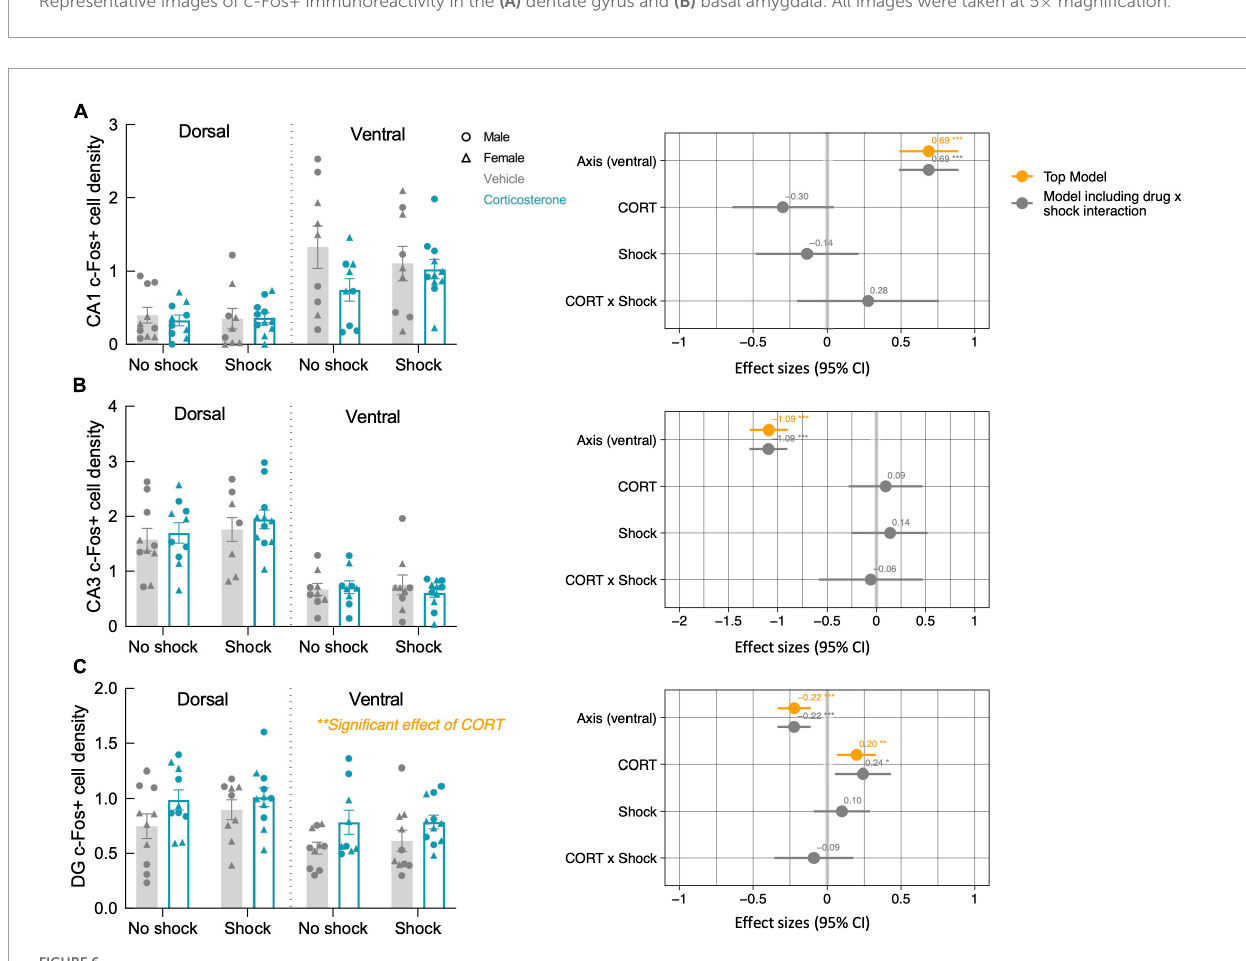
regions included only axis as a predictor, indicating that neural activity was higher in the ventral area ( Table 1 ). The models that included corticosterone treatment and shock as predictors did not fit the data as well, and the effect sizes for these predictors were not significant. In the dentate gyrus, animals treated with corticosterone had greater c-Fos+ cell density compared to animals treated with vehicle ( Figure 6C ; P = 0.002), suggesting greater activation of the dentate gyrus during context re-exposure in